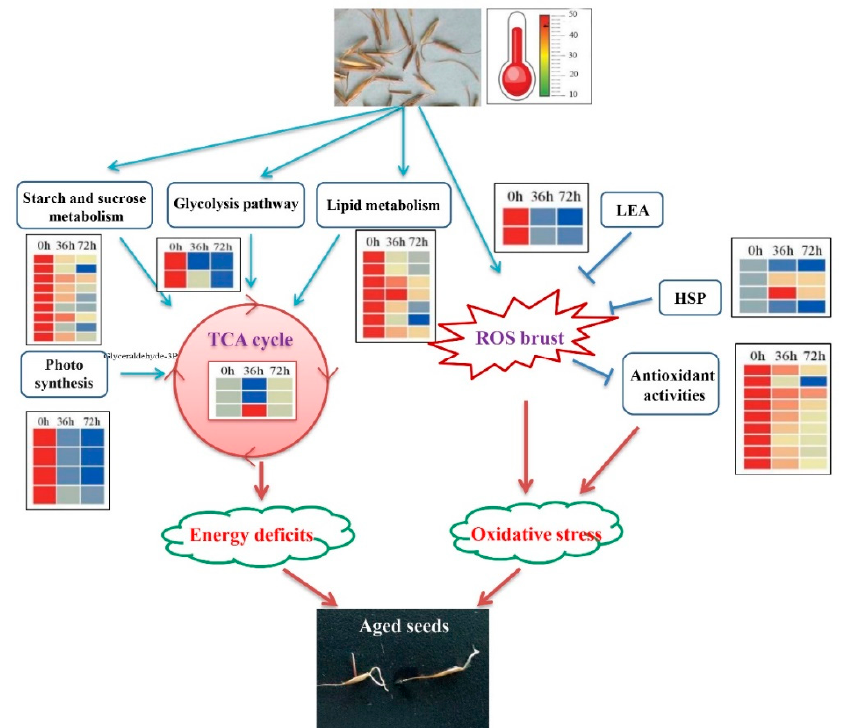
Figure 5. The overview of differentially modulated proteins during AAT. Reactive oxygen species, ROS; Late embryogenesis abundant proteins, LEA; Heat shock proteins, HSP; tricarboxylic acid cycle, TCA cycle.